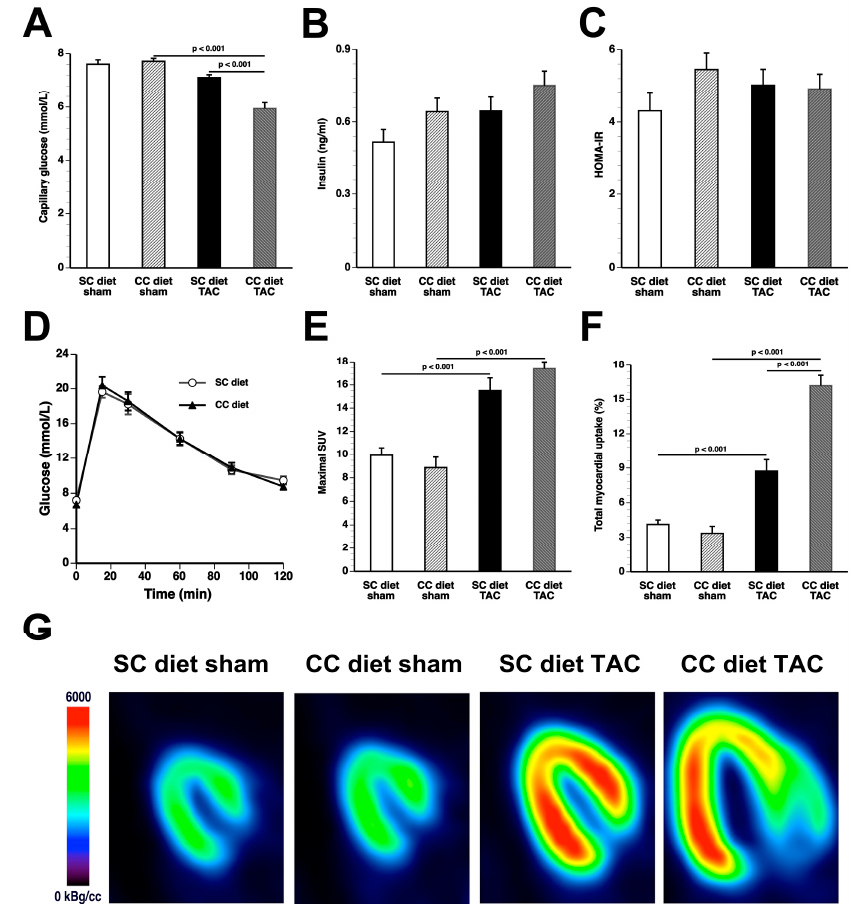
( A ); plasma insulin levels ( B ); and HOMA-IR values ( C ) in SC diet sham, CC diet sham, SC diet TAC, intraperitoneal glucose tolerance test in SC diet mice and in CC diet mice ( D ). Quantification